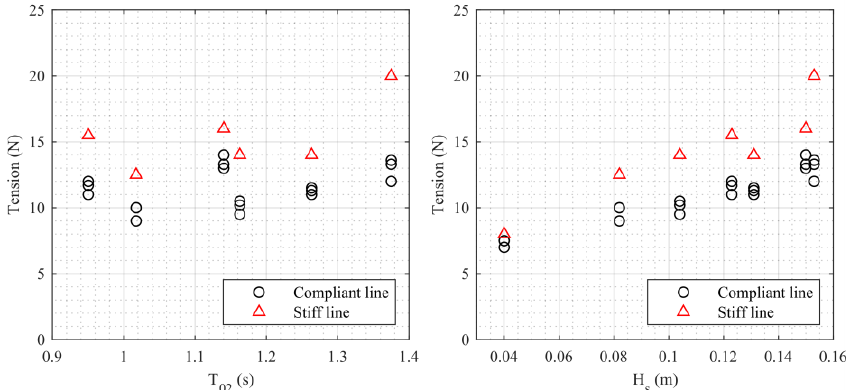
Figure 17. Experimentally measured maximum tensions in model-scale values for the compliant line (series M2, M3, M5) and stiff line (Series M6) as function of wave period ( left ) and wave height ( right ).